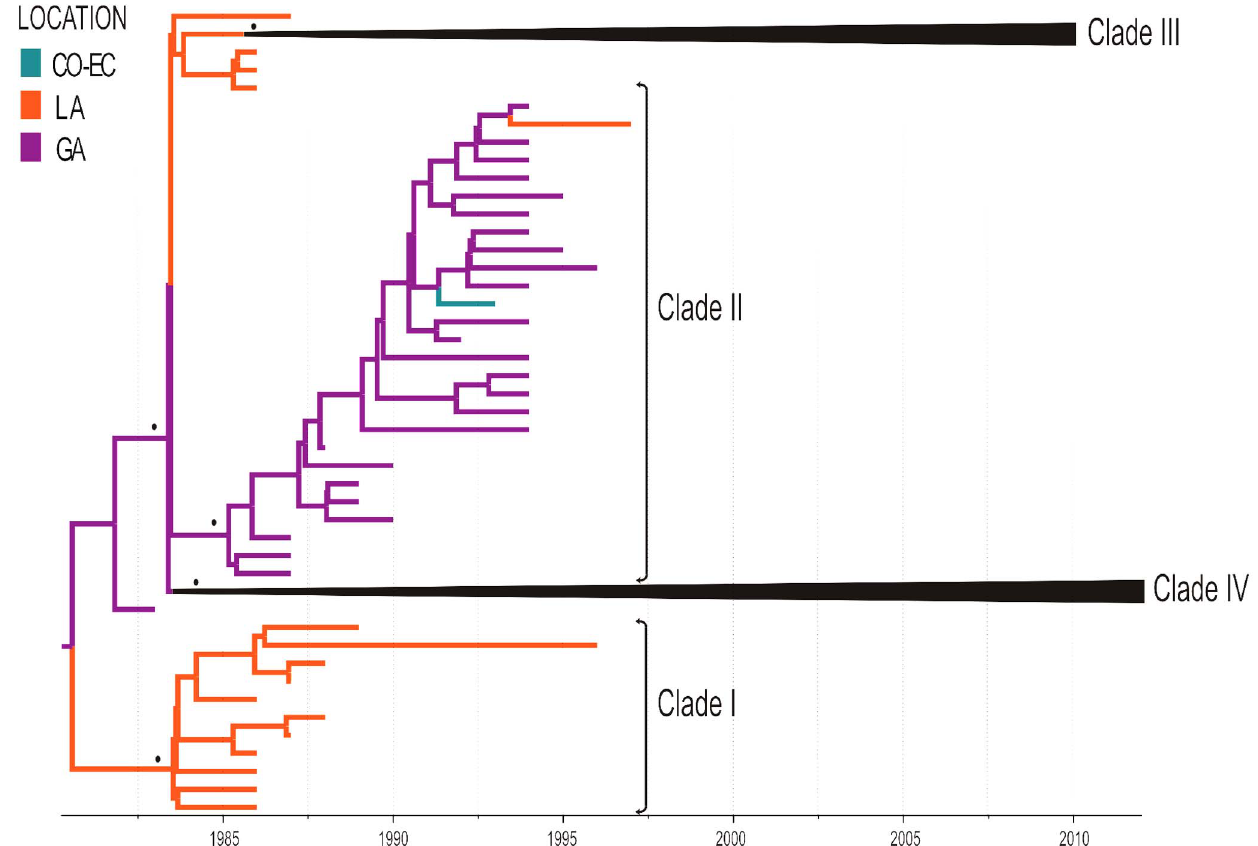
Figure 4. Time-scaled Bayesian Maximum Clade Credibility tree for the DENV-2 AS-AM genotype. Four major highly supported monophyletic clades (I-IV) are identified. Branches are colored according to the most probable location (legend shown on the left side) of their parental node inferred by discrete phylogeographical analysis. For visual clarity, clades III and IV has been collapsed (see Fig.5 and Fig.6). PP values . 0.90 at key nodes are represented by (*). All horizontal branch lengths are drawn to a scale of years. The tree is automatically rooted under the assumption of a relaxed molecular clock. (CO-EC: Colombia-Ecuador, LA: Lesser Antilles, GA: Greater Antilles)